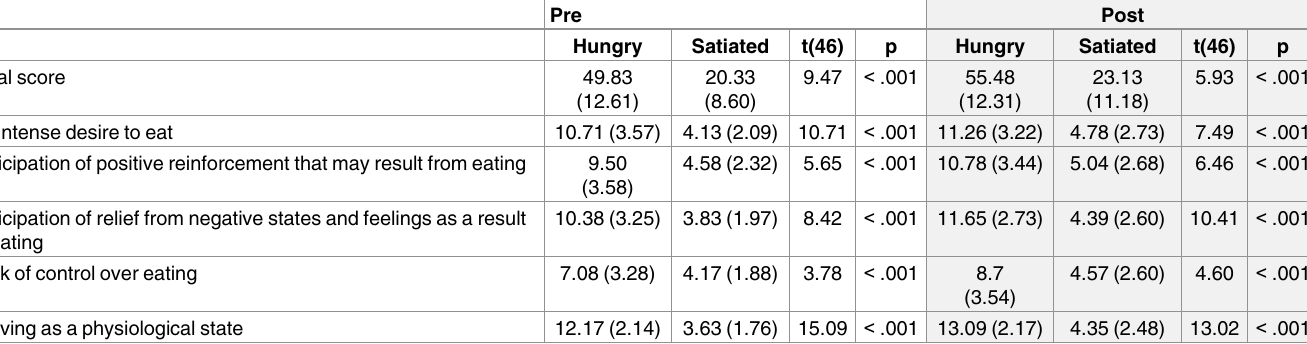
Values within parentheses represent the standard deviation.